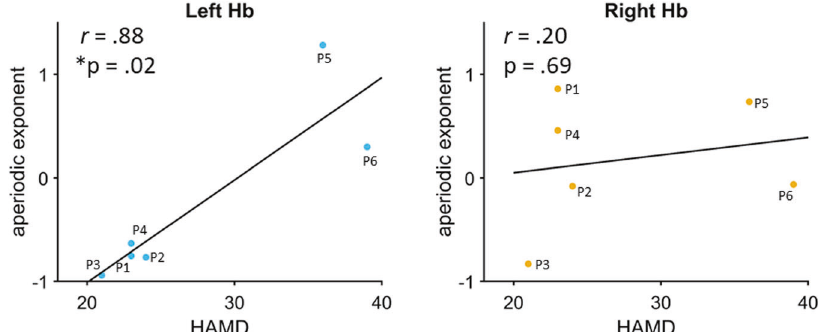
Fig. 3 Relationship of aperiodic component with depression scores. The aperiodic component of left habenula (Hb) (blue) showed a positive correlation with baseline depression scores measured using the Hamilton depression rating scale (HAMD) with no signi fi cant relationship observed for the right habenula (yellow). Bonferroni correction * P <